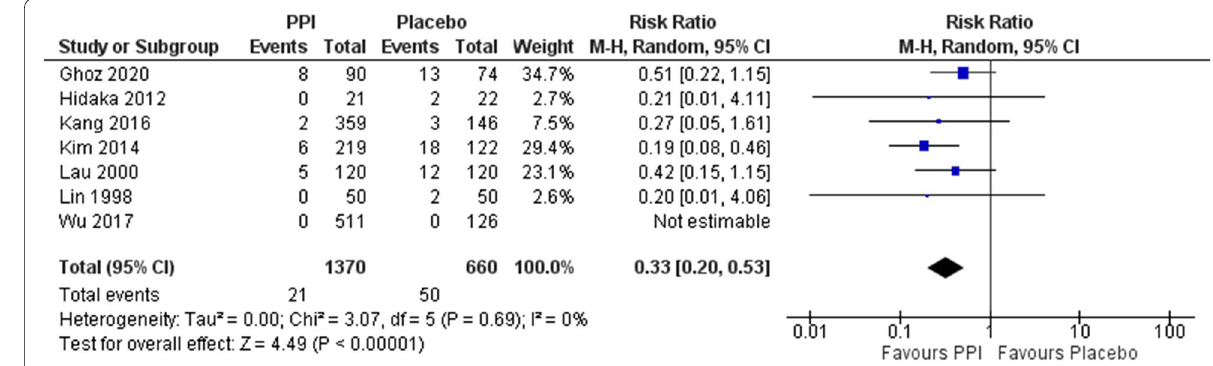
Fig. 5 Forest plot of bleeding related death